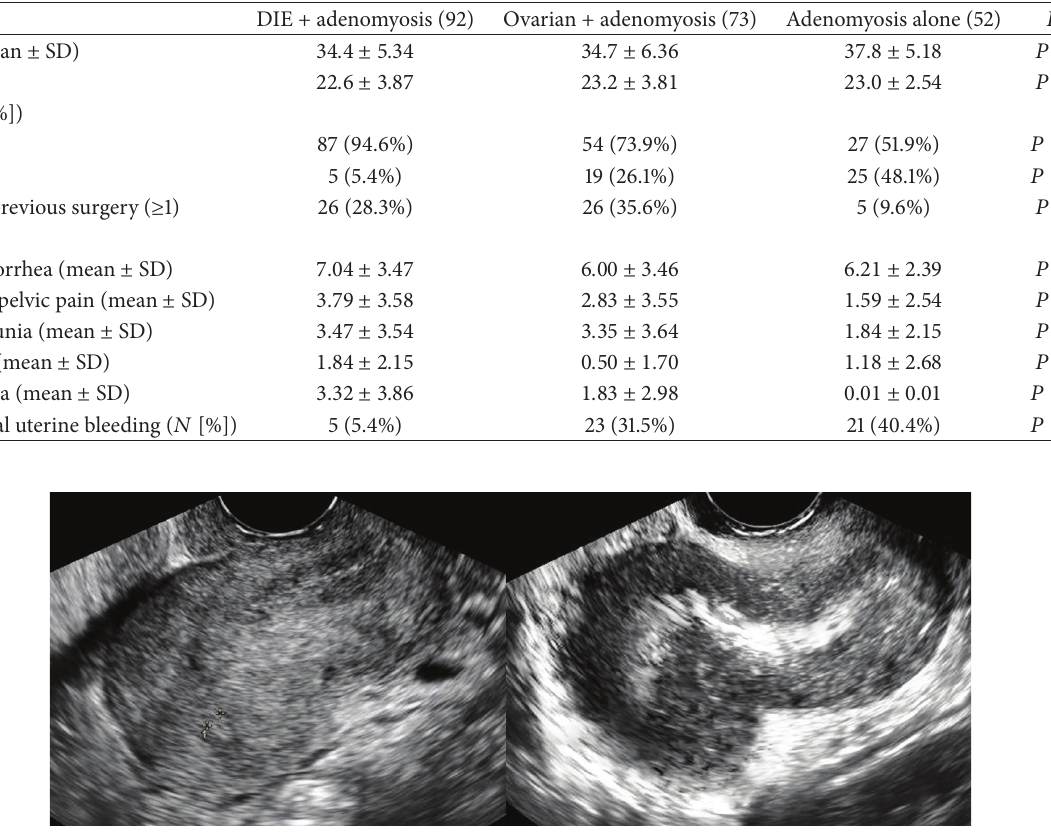
Table 2: Demographic and clinical characteristics in the different patient groups.